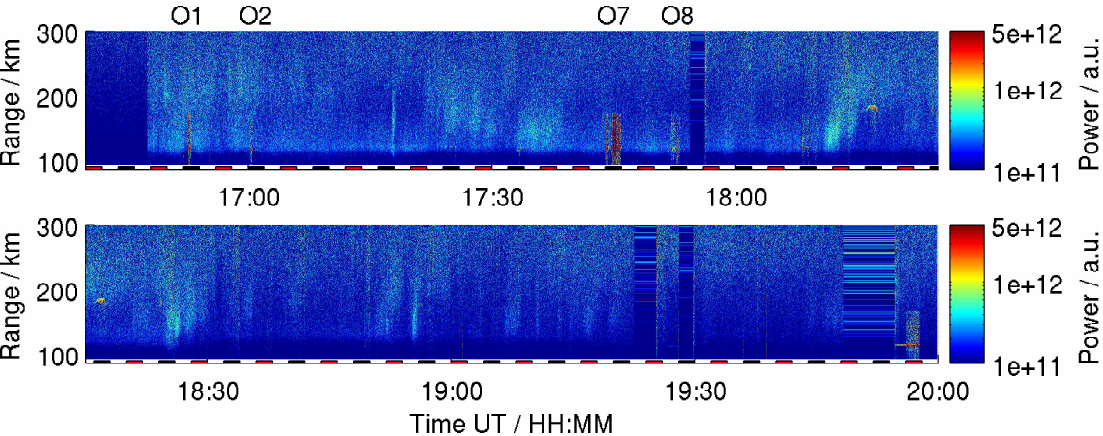
Fig. 1. Overview of radar data obtained during the heating experiment, shown is the radar power profile. The red and black inlays at the bottom of the panels indicate heater on X mode and O mode,